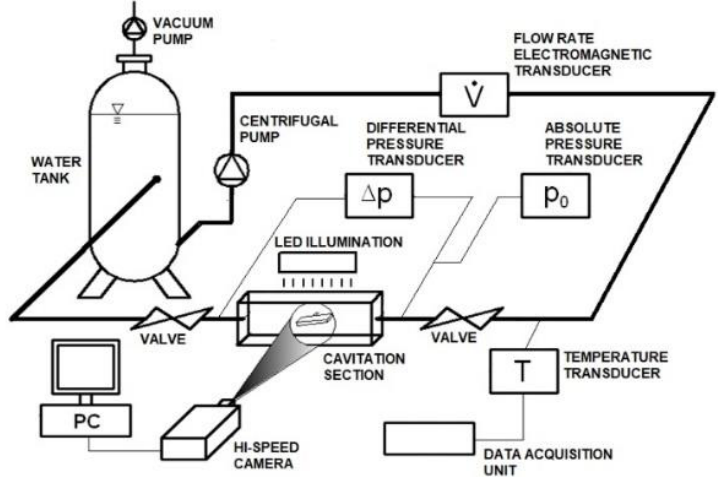
Figure 7. Cavitation measuring station with measuring and visualization equipment. The cavitation tunnel test section cross-section was 50 cm × 100 cm. Hydrofoil width was 50 mm and chord length was l = 60 mm. The hydrofoil was installed at the angle of attack 8°.